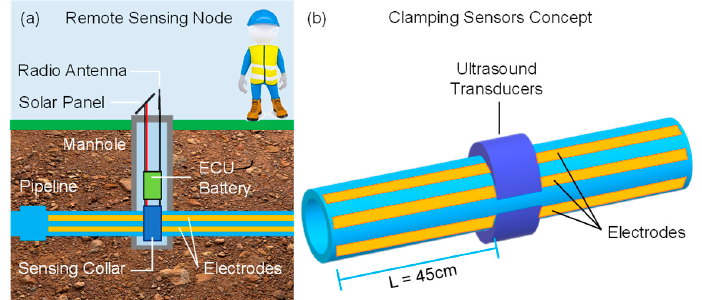
Figure 1. Envisioned smart water sensing node connected to an underground pipe ( a ) on which piezoelectric and impedance sensors are externally applied ( b ).